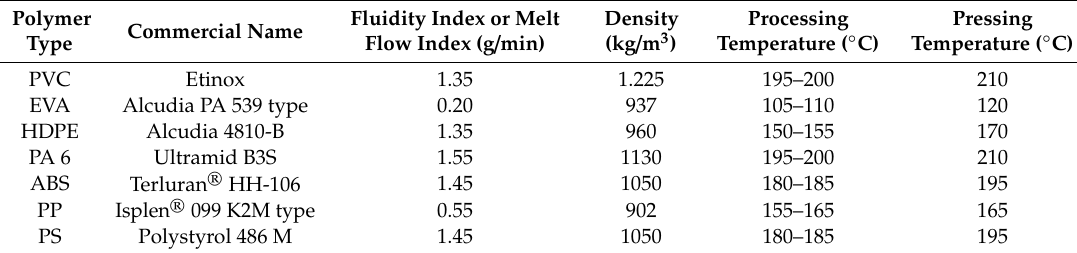
Table 2. The physical properties and processing temperatures of the mixing machine. The pressing temperatures were at a constant pressure of 200 bar for each material. Polyvinyl chloride (PVC); high-density polyethylene (HDPE); ethylene vinyl acetate (EVA); polypropylene (PP);